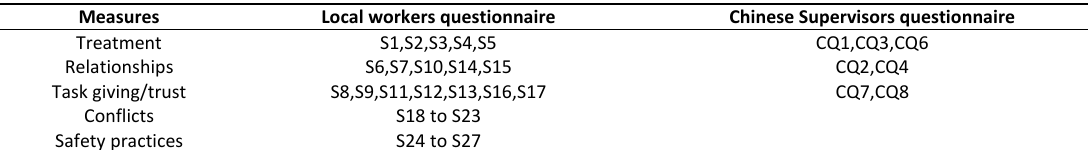
Fig. 2: Conceptual hypotheses stated on hydropower projects in Cameroon Table 1: Questions statements mapping